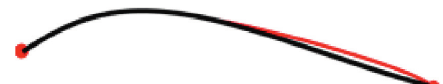
Figure 24: Cubic spline fitted for 2nd iteration of GA.